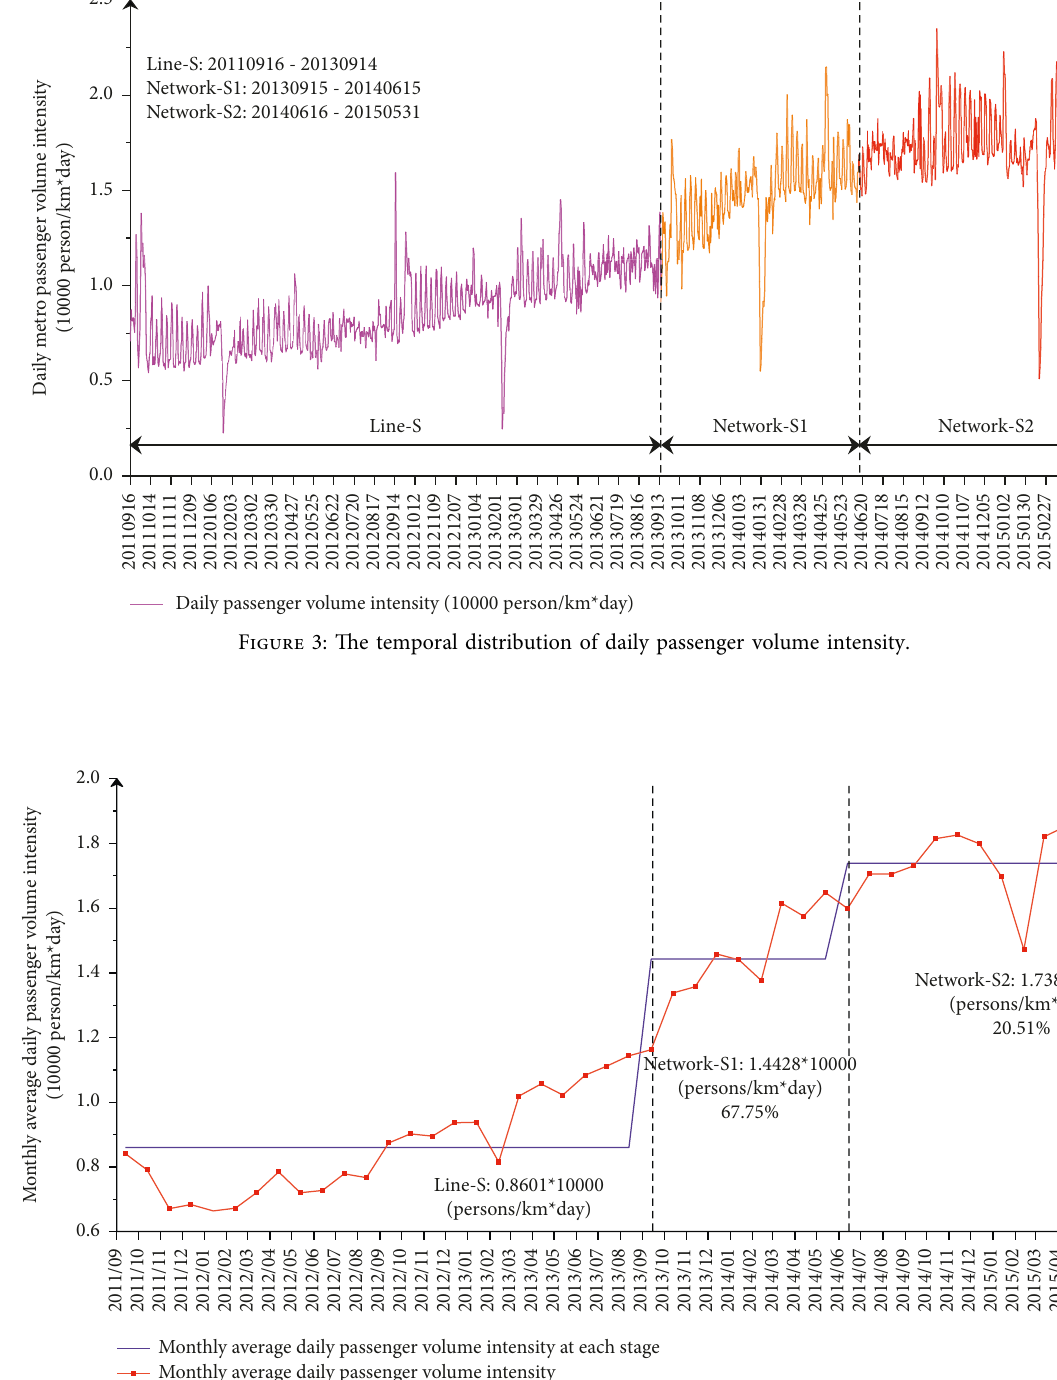
Figure 4: The temporal distribution of monthly average daily passenger volume intensity.